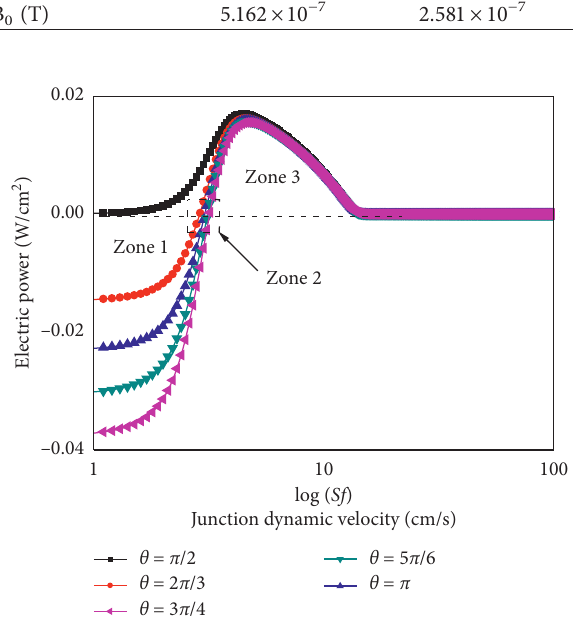
Figure 2: Power output as function of junction dynamic velocity for different incidence